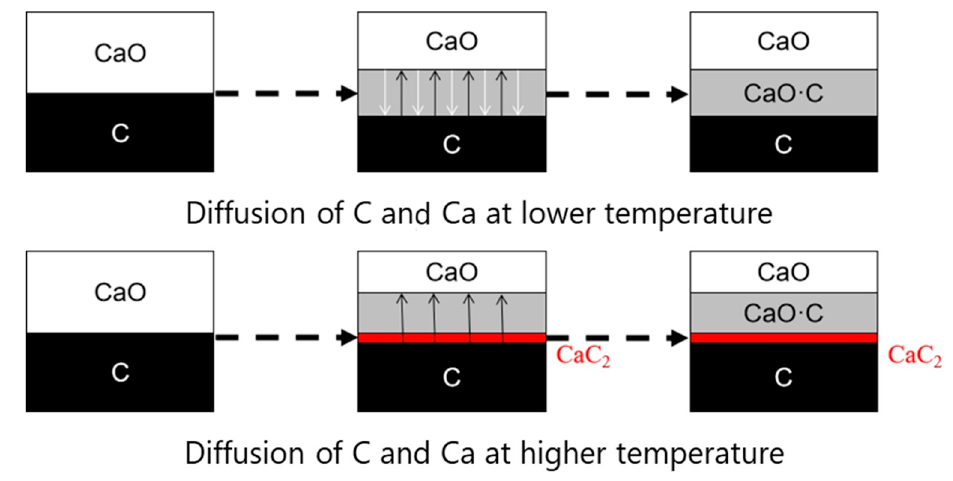
Figure 11. The schematic diagram of the diffusion of C and CaO in the MW field .